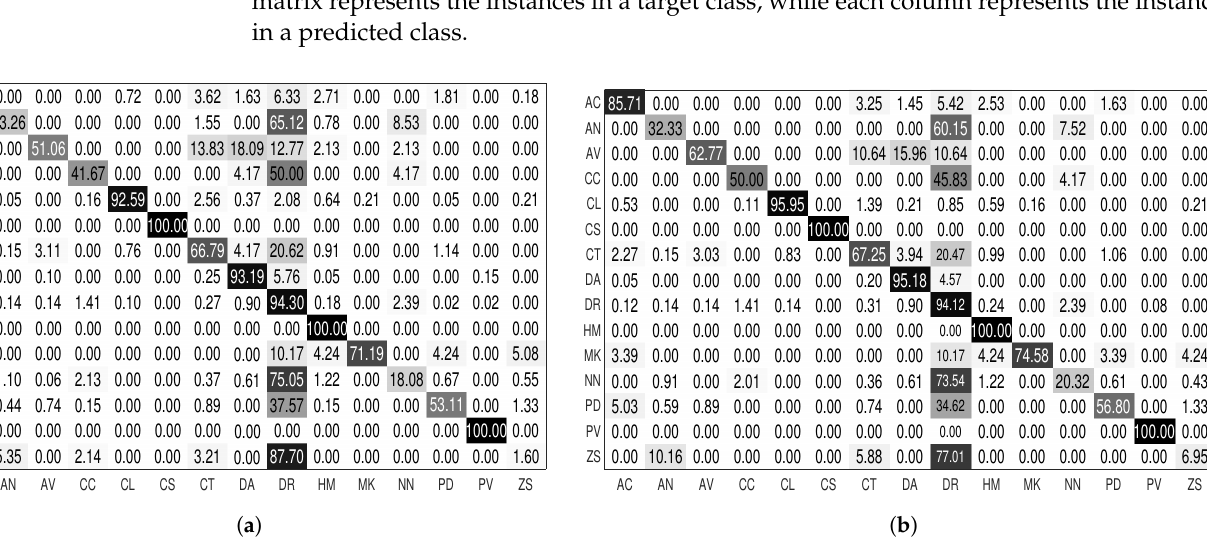
Figure 10. Confusion matrix of CNN transfer learning approach without ( a ) and with ( b ) targeted data augmentation for the LCF-15